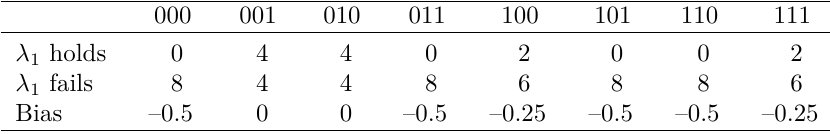
Table 16: Conditioning ε ( λ 1 ) on Each of the 8 Values of the 3 Selected Input Bits of S